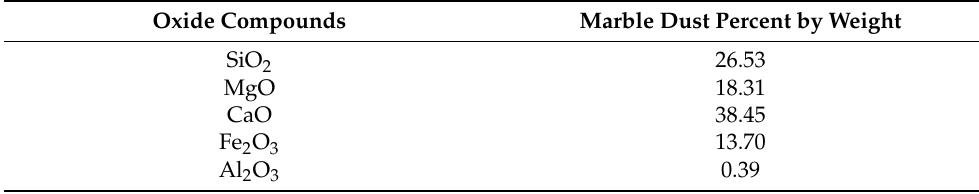
Table 1. Chemical composition of marble